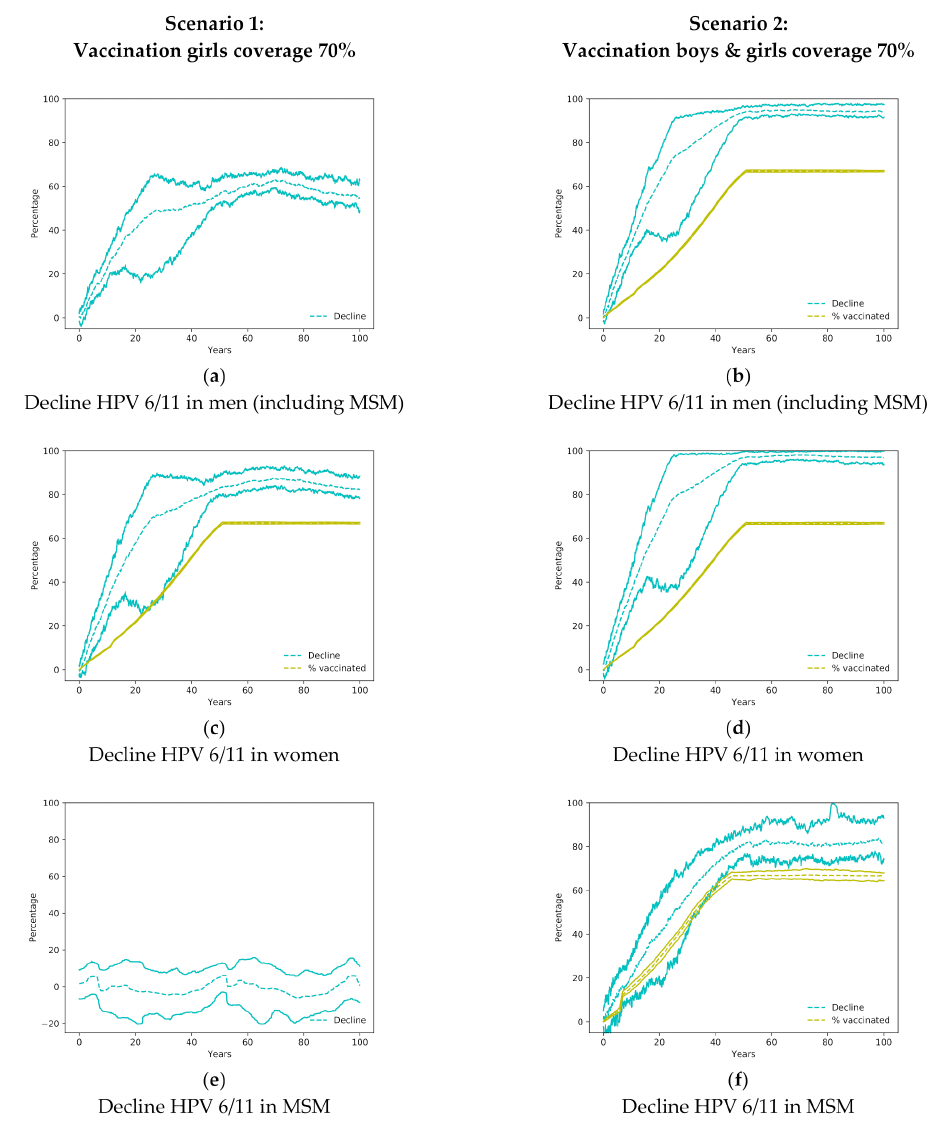
Figure 1. Decline of HPV 6/11 in men, MSM and women in the simulated scenarios 1 and 2. In the figures where a yellow line appears denoting the percentage of vaccinated, the difference between the yellow line and the blue lines is a measure of the community effect. MSM: men who have sex with men; HPV: Human Papilloma